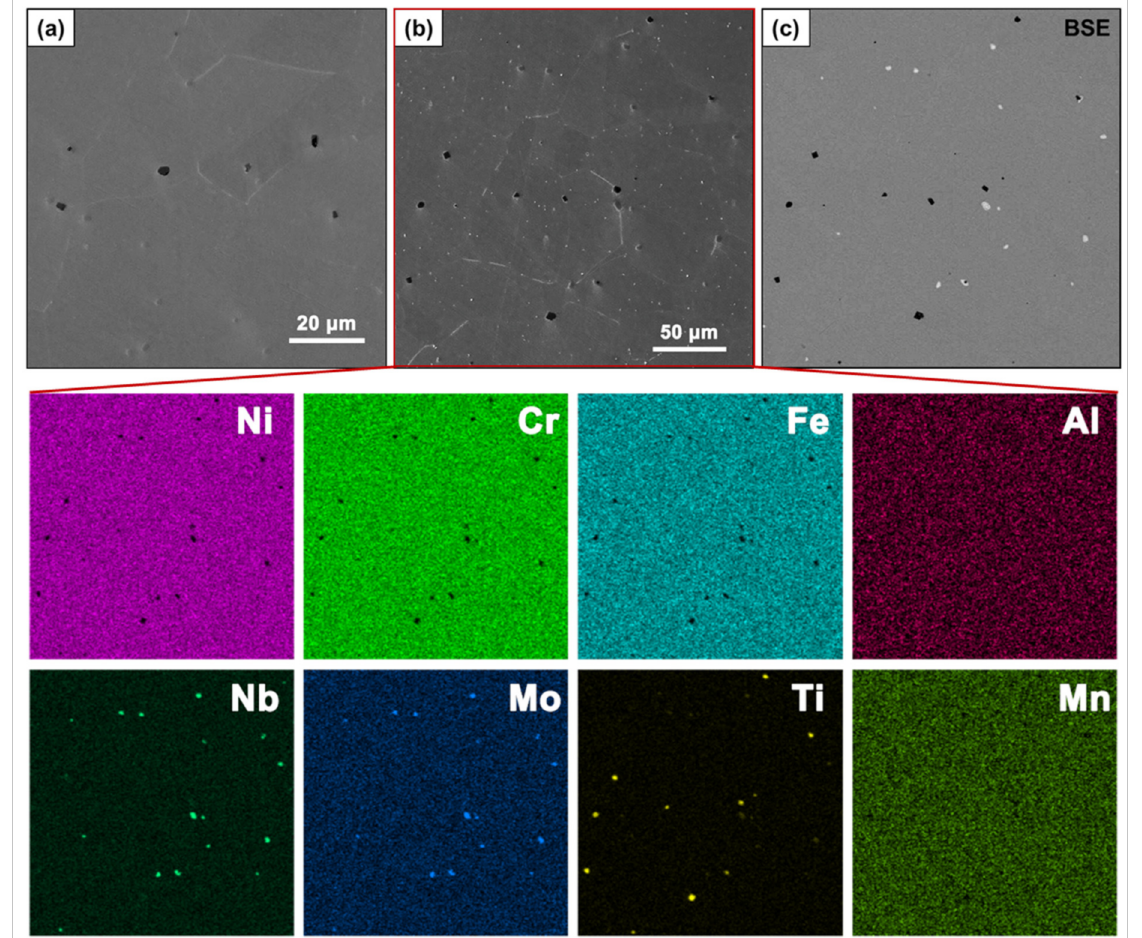
Figure 2. The SEM micrograph and the EDS mapping distributions of the aging treatment samples, ( a ) secondary electron image of the non-heat treated sample, ( b ) secondary electron image of the 945A-32h sample and ( c ) BSE image of the 945A-32h sample. The EDS mapping images were detected in the area of Figure